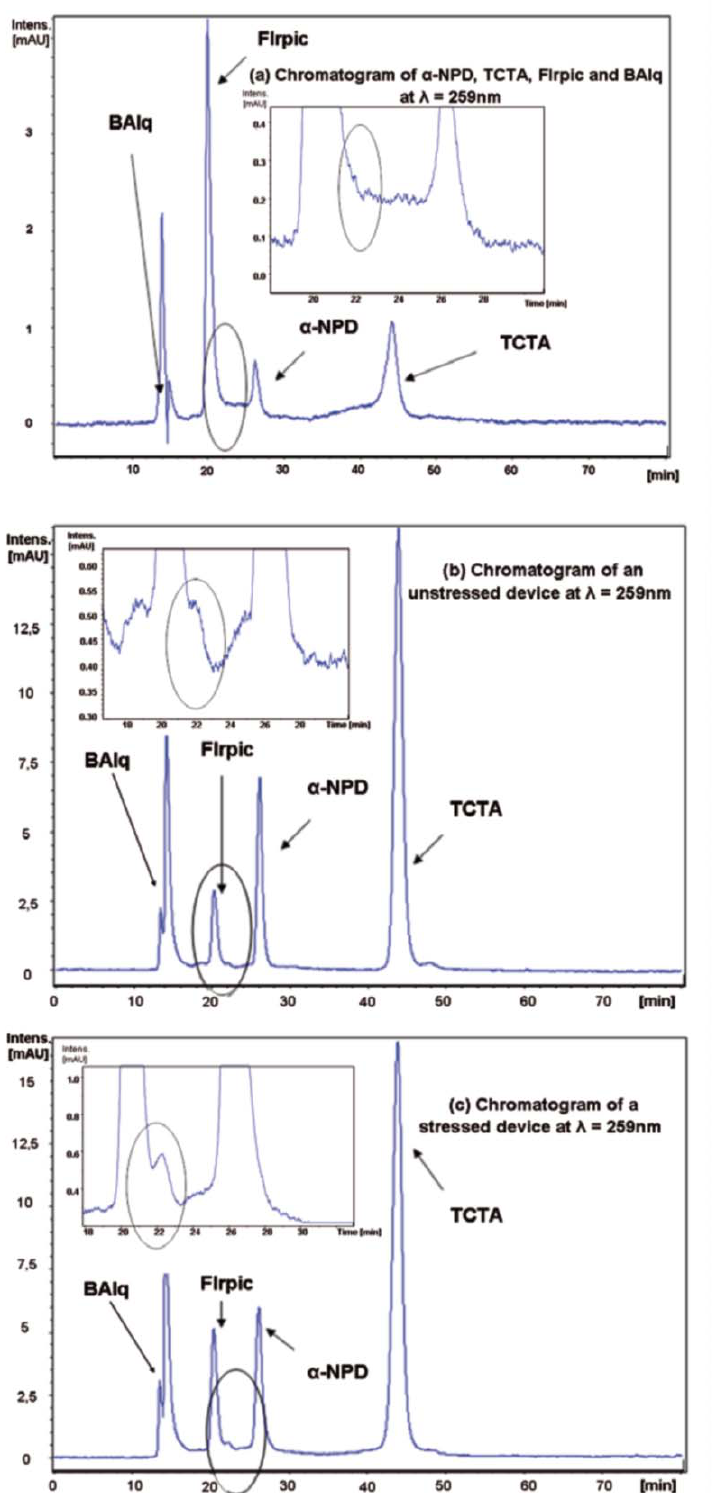
Figure 1. LC/UV chromatogram of (a) pure materials α -NPD, TCTA, FIrpic and BAlq; (b) unstressed device and (c) stressed device at λ = 259